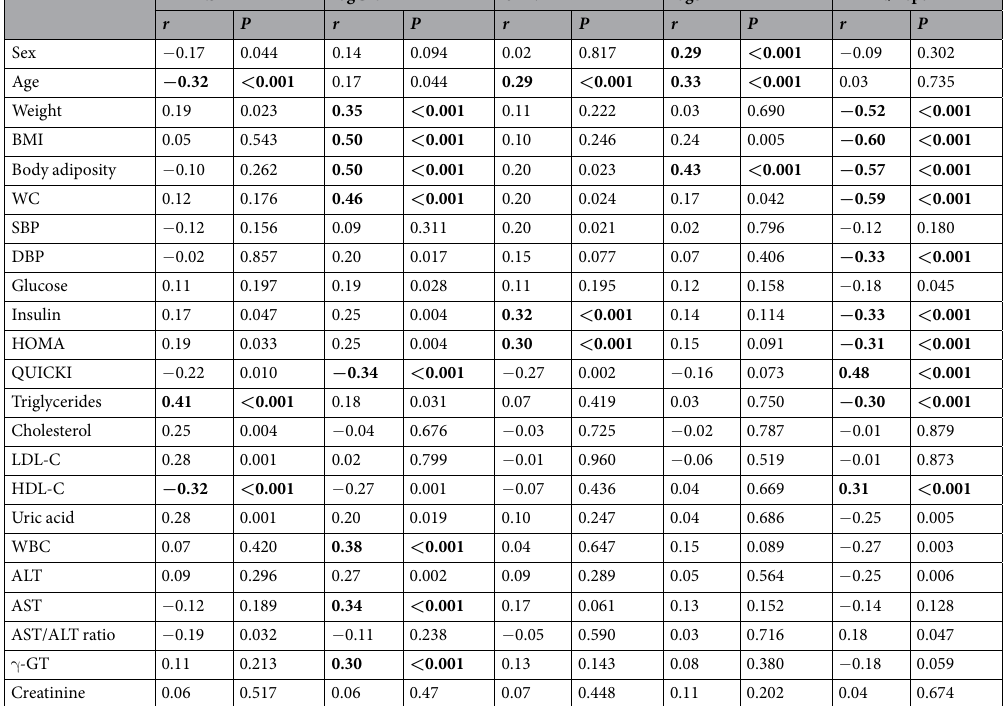
Table 2. Univariate analysis of the correlation of markers of inflammation and oxidative stress with anthropometric and biochemical variables in the subjects included in the study. TBARS, thiobarbituric acid reactive substances; CRP, C-reactive protein; OPN, osteopontin; SAA, serum amyloid A; ADPN, adiponectin; BMI, body mass index; WC, waist circumference; SBP, systolic blood pressure; DBP, diastolic blood pressure; HOMA, homeostatic model assessment; QUICKI, quantitative insulin sensitivity check index; LDL-C, low- density lipoprotein-cholesterol; HDL-C, high-density lipoprotein-cholesterol; WBC, white blood cells; ALT, alanine aminotransferase; AST, aspartate aminotransferase; γ -GT, γ -glutamyltransferase. Data are Pearson’s correlation coefficients and associated P values. For correlation with gender, male = 0 and female = 1 was used. Those correlations with a P lower than 0.001 are highlighted in